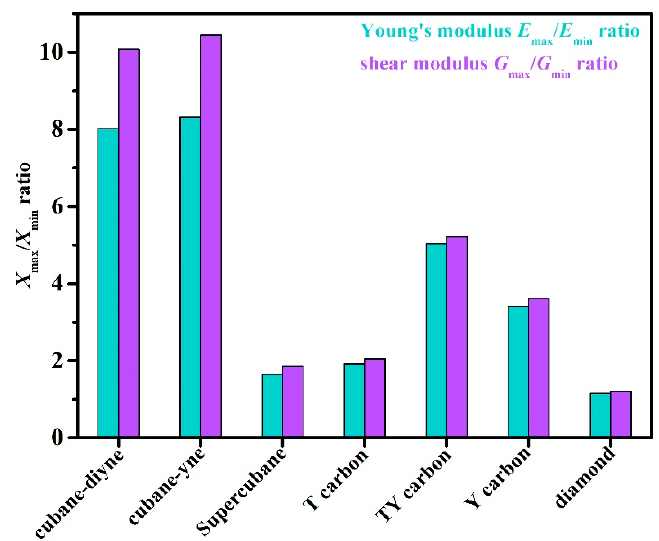
Figure 3. The E max / E min ratio and G max / G min ratio of supercubane, T carbon, Y carbon, TY carbon, cubane-diyne, cubane-diyne, and diamond.